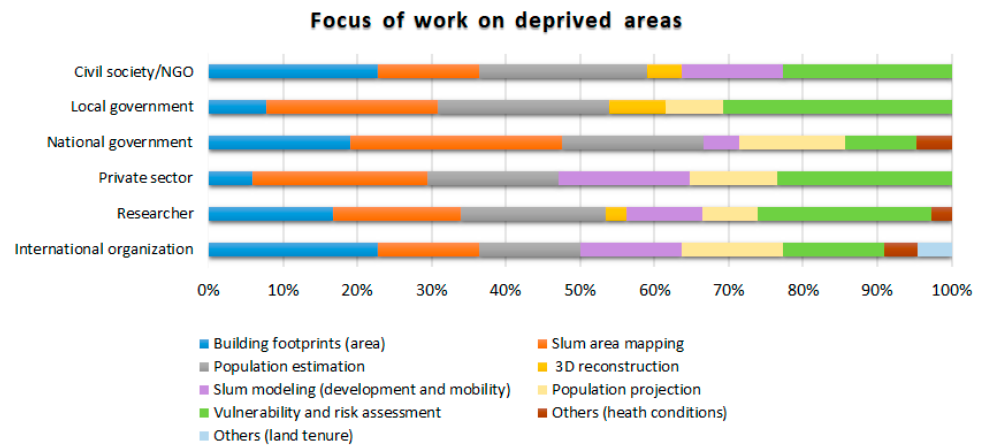
Figure 9. Results of online expert survey on the focus of work concerning deprived areas related data (multiple answers).